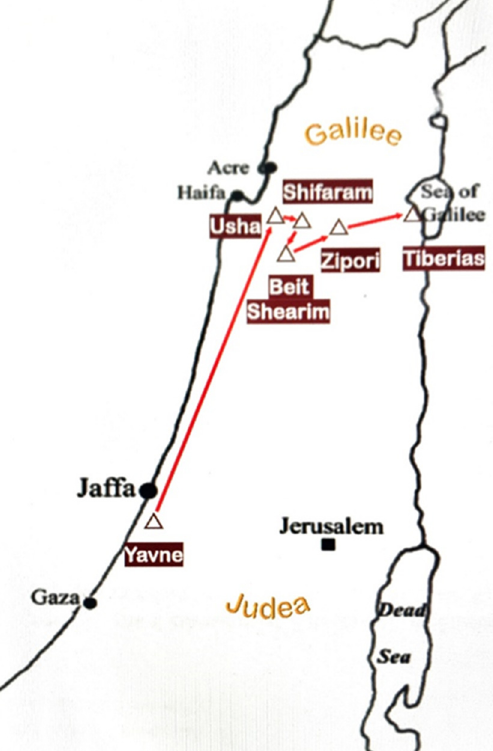
Figure 4. Exile of the Sanhedrin. To avoid restrictive edicts by the Roman Legate, the Sanhedrin (the religious and administrative leadership of the Jews at the time of the Mishna) relocated near the end of the 1st century from Yavne, a Mediterranian salt-water coastal town in Judea at the center of the country, northward to the Galilee, eventually ending up in the city of Tiberias on the shore of the freshwater Sea of Galilee by the latter part of the 2nd century.